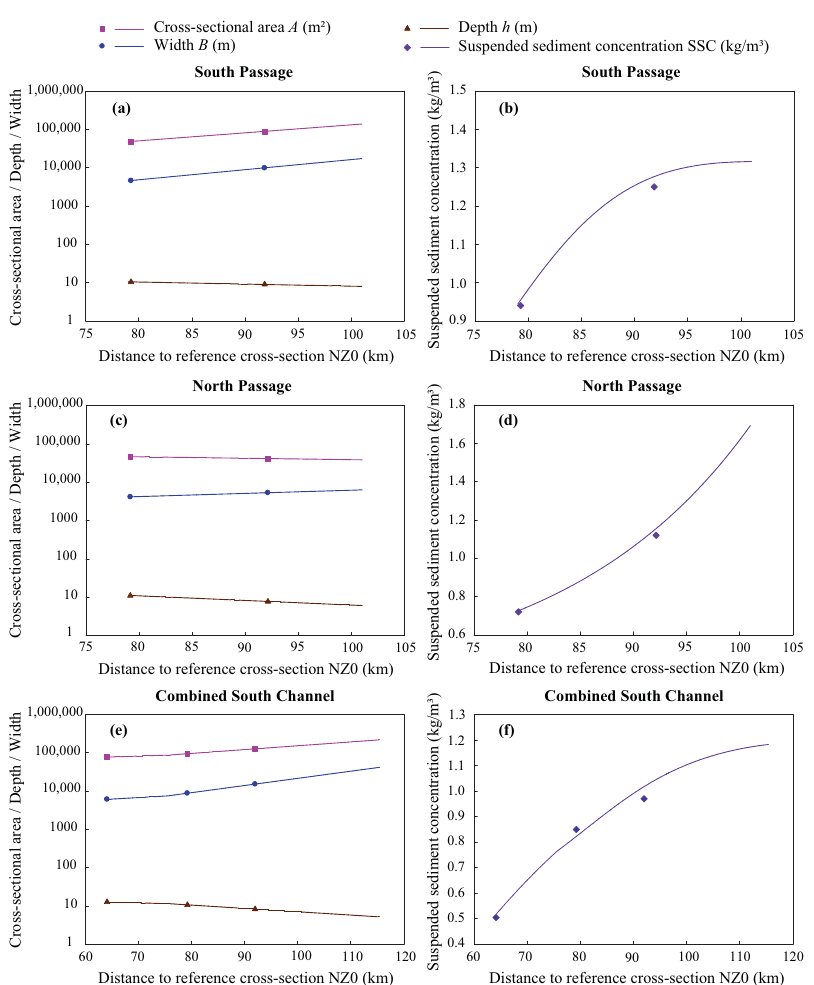
Figure 3. The computed topography and SSC distribution for the South Passage ( a , b ), North Passage ( c , d ), and the combined South Channel ( e , f ) on 30–31 January 2010, compared to observations. (Scatters represent observations, and the drawn lines represent the simulated